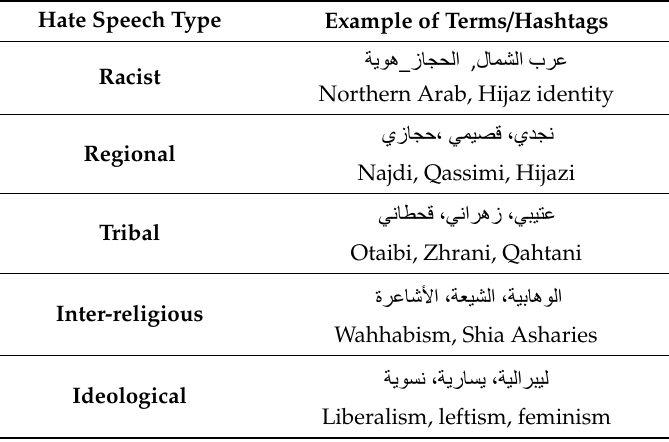
Table 1. Examples of terms used for data retrieving.